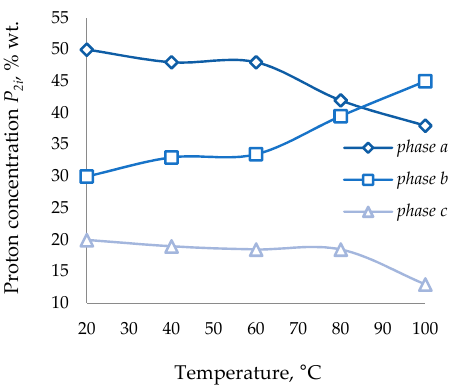
Figure 2. Proton concentration P 2 i of HRO vs. temperature.